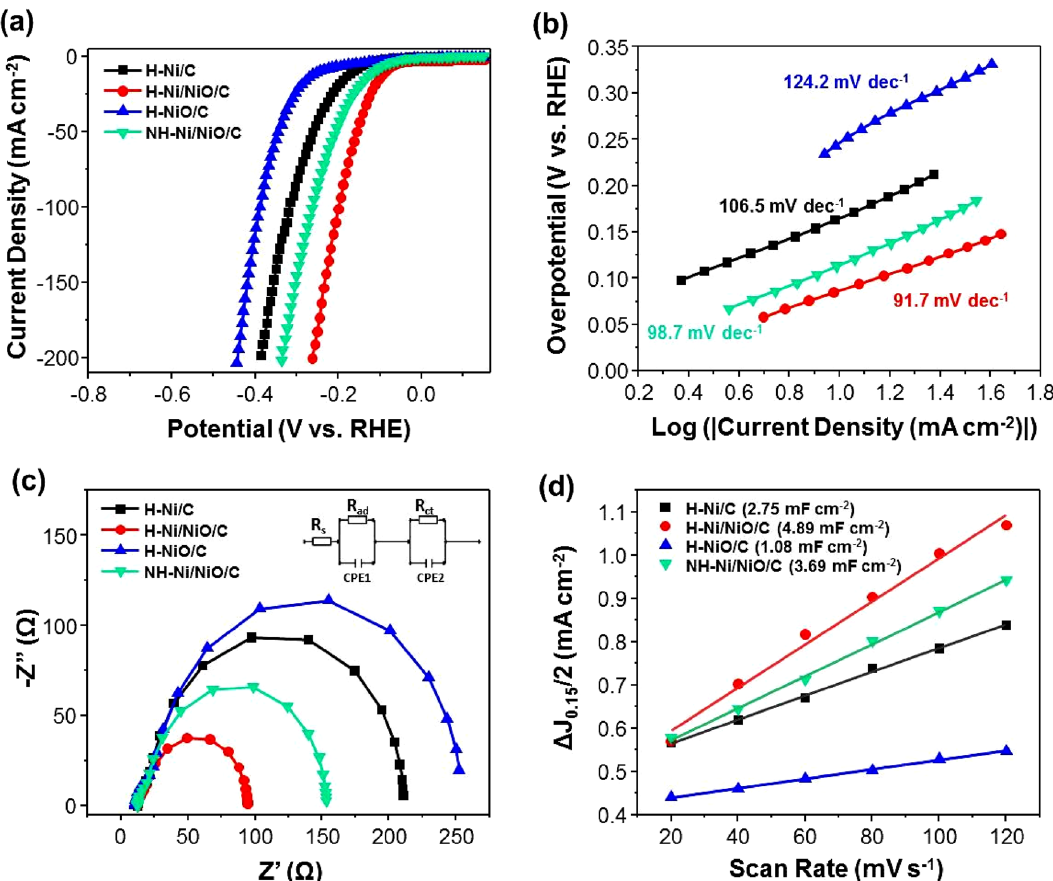
Fig. 5 a Polarization curve of H–Ni/C, H–Ni/NiO/C, H–NiO/C, and NH–Ni/NiO/C. b Tafel slope of catalysts, c Nyquist plots of different samples recorded at a potential of 0.2 V vs. the RHE. d Double-layer capacitances of various samples obtained using −